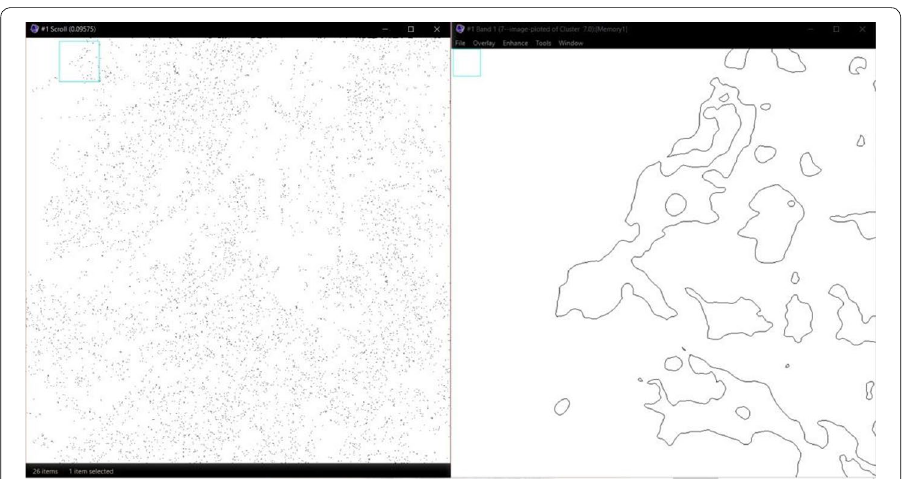
Fig. 10 Highlighting the boundaries of Cluster No. 7 in 8k